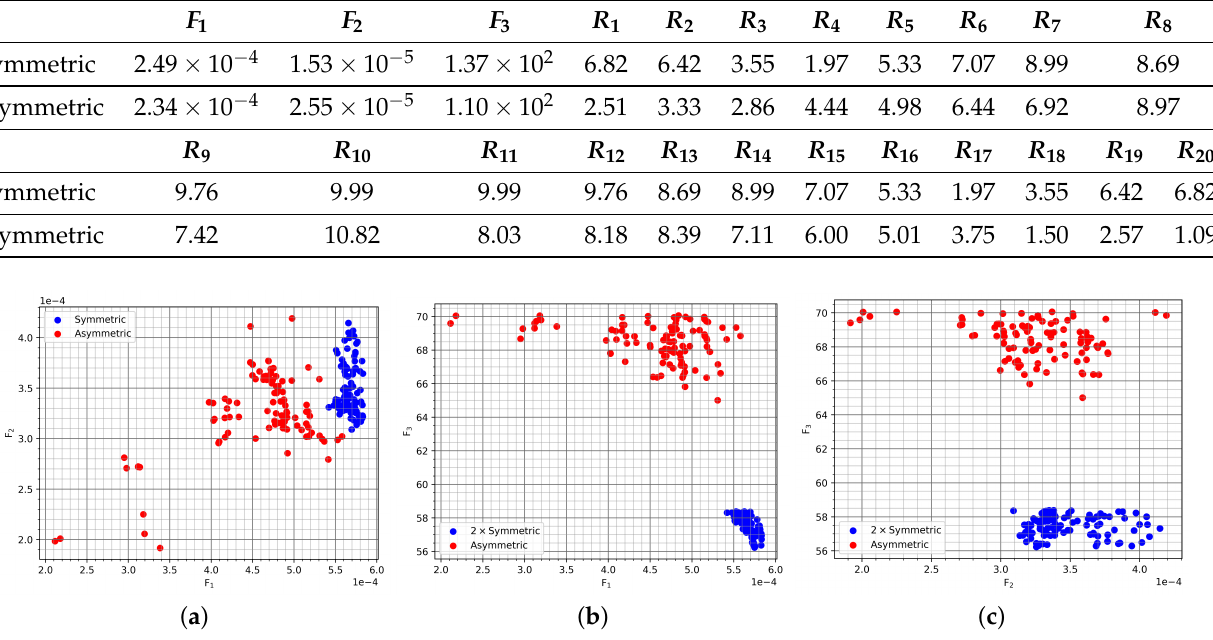
Figure 9. The image shows the distribution of the 100 cheapest individuals ( F 3 ) in case ( a ). The blue dots show the symmetric setups, while the asymmetric solutions are depicted in red. ( a ) The distribution of individuals on the F 1 – F 2 axis. ( b ) The distribution on the F 1 – F 3 axis. ( c ) The distribution on the F 2 – F 3 axis.